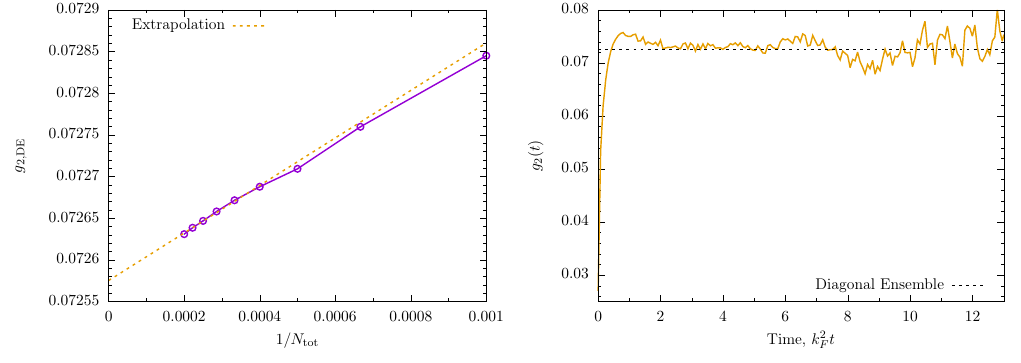
Figure 15: The scaling with N of the diagonal ensemble result (left panel) for tot = 20 → c = 10 quench with N = 10 particles. The dotted line shows a linear c i f = ∞ . A comparison of the N = 3500 data of Fig. 13 with the extrapolation to N tot tot extrapolated diagonal ensemble result for the long time limit (right